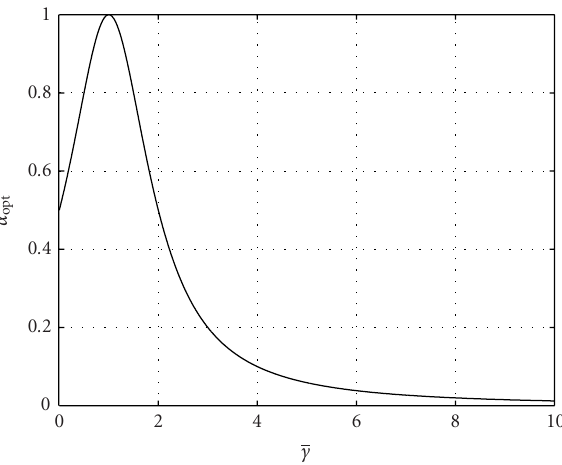
Figure 5: Optimal smoothing parameter α opt as a function of the smoothed a posteriori SNR γ ( k , m